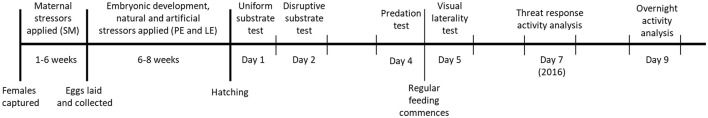
Timeline of stress treatments and behavioral tests. All tests except for the threat response activity analysis occurred in 2015.